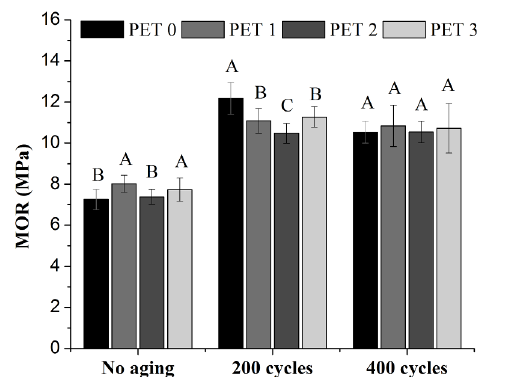
Figure 6. Average and standard deviation values of modulus of rupture of fiber-cement composites with PET particles. Consecutive means of the same letter do not statistically differ by the Scott-Knott mean test, at 5% of significance. PET1= 20 to 24 mesh, PET2= 24 to 32 mesh and PET3 = 32 to 35